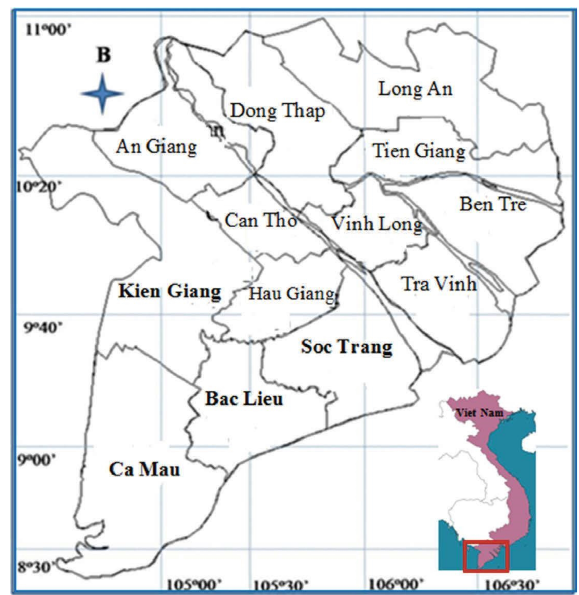
Figure 1: Research